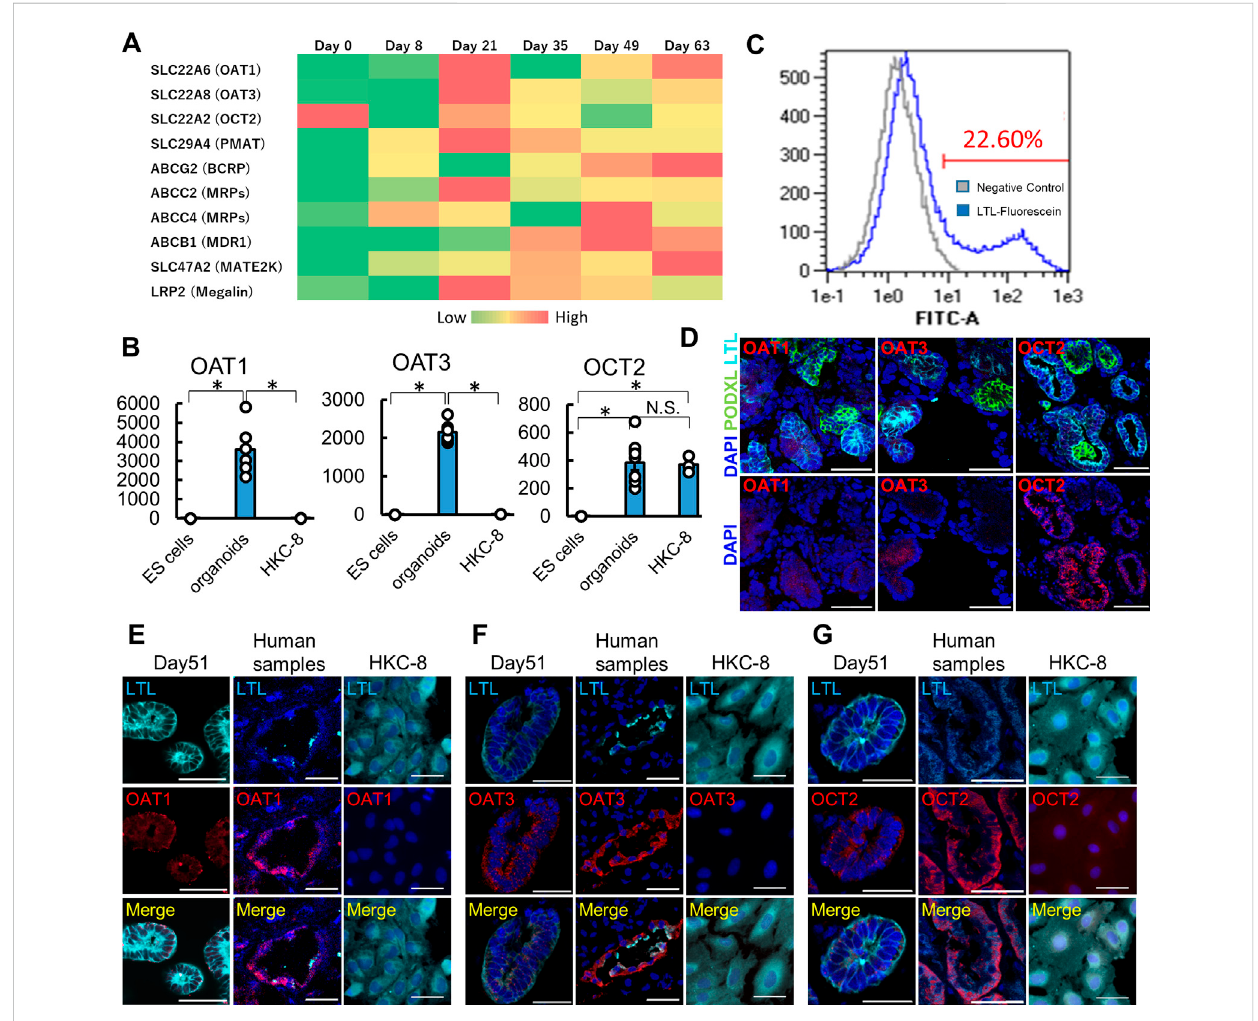
FIGURE 2 Maturation-dependentexpressionofrenaldrugtransportersinkidneyorganoids,andcomparisonwithhumankidneysandHKC-8culturedcells. (A) HeatmapforRNA-seqofdrugtransportersicludingOAT1,OAT3,OCT2,andPMATinundifferentiatedEScells(day0),nephronprogenitorcells(NPC,day 8), and kidney organoids (day over 21). n = 3 to 9. (B) qPCR of OAT1, OAT3, and OCT2 in undifferentiated ES cells, kidney organoids (day 21), and HKC8 cells. n = 3 to 9. * p < 0.05. (C) Gating of dissociated organoids by LTL. Even though only 22.60% of dissociated cells from organoids showed LTL positive, the mRNA level of OCT2 from organoids was comparable to that of HKC-8. (D) Localization of OAT1, OAT3, and OCT2 in kidney organoids (day 21). IF of podocalyxin (PODXL, green), LTL (cyan), OAT1 (red), OAT3 (red), and OCT2 (red). Podocytes did not express OAT1, OAT3, and OCT2 in kidney organoids. (E – G) Immuno fl uorescence (IF) of LTL (cyan), OAT1 (red), OAT3, and OCT2 in kidney organoids (day 51), human kidney samples, and HKC-8 cells. Scale bar: 50 μ m.